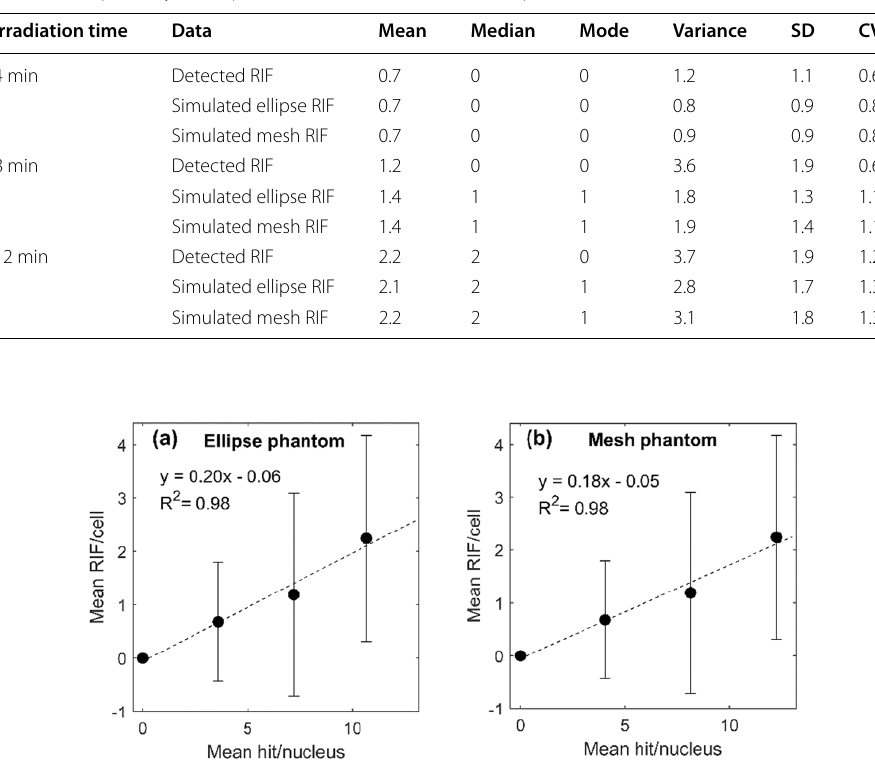
Fig. 7 Mean number of RIF per cell nuclei as a function of simulated mean number of hits per cell nuclei for the elliptical cylinder phantom ( a ) and the mesh volume phantom ( b ), respectively. Error bar 1 regression by linear least squares method seen as dotted